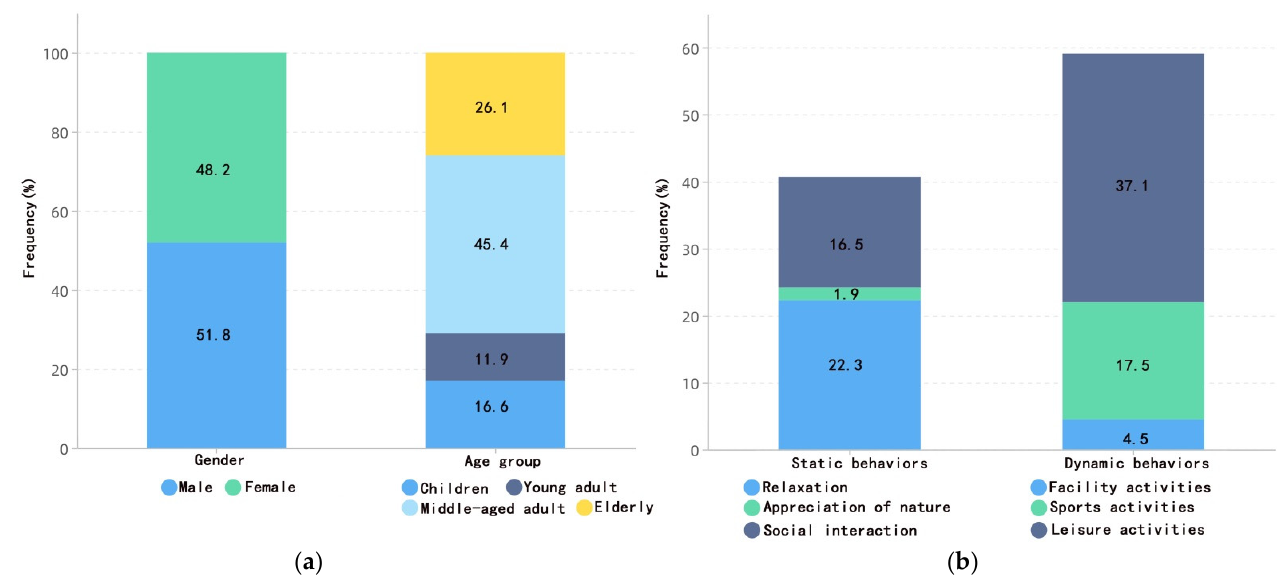
Figure 6. ( a ) Percentage of basic attributes of visitors. ( b ) Percentage of behavioral patterns of visitors.